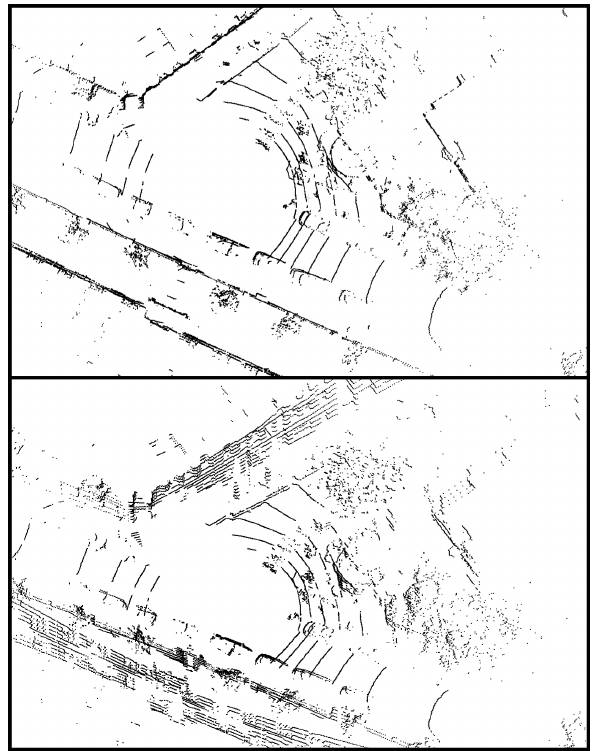
Figure 2. Top (upper) and perspective (lower) view of an example point cloud for a crossing scene.